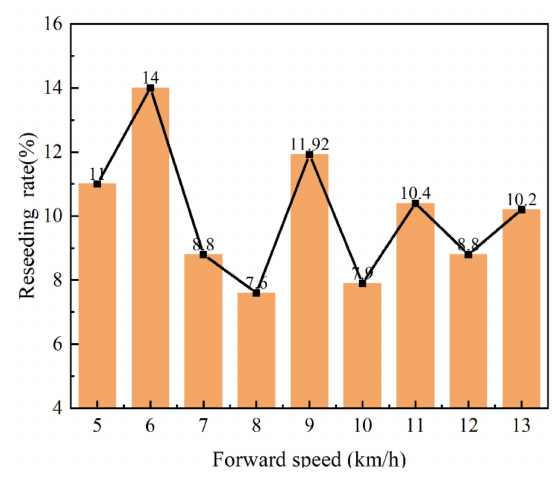
Figure 14. Coefficient of variation.